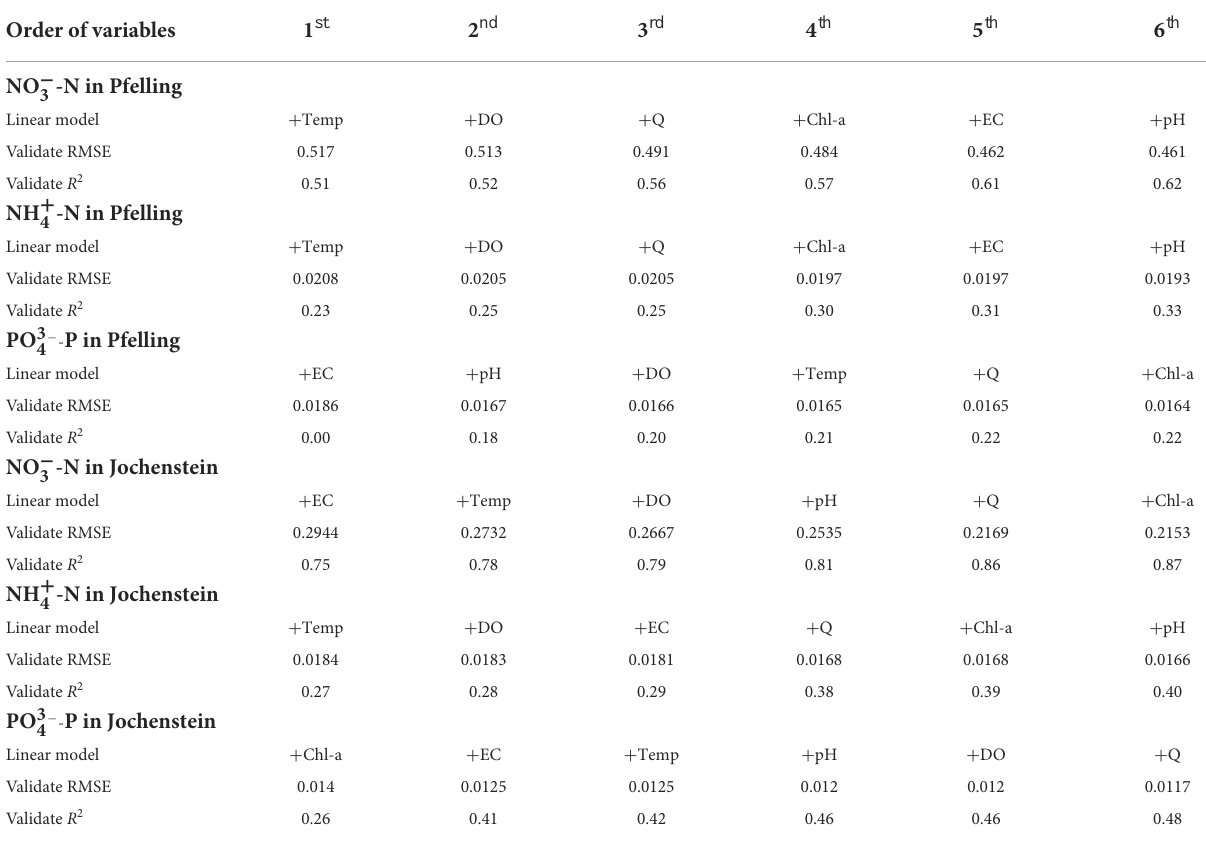
TABLE 5 Validation RMSE for each target variable and each subset of variables of size one to six in the MLR model. Order of